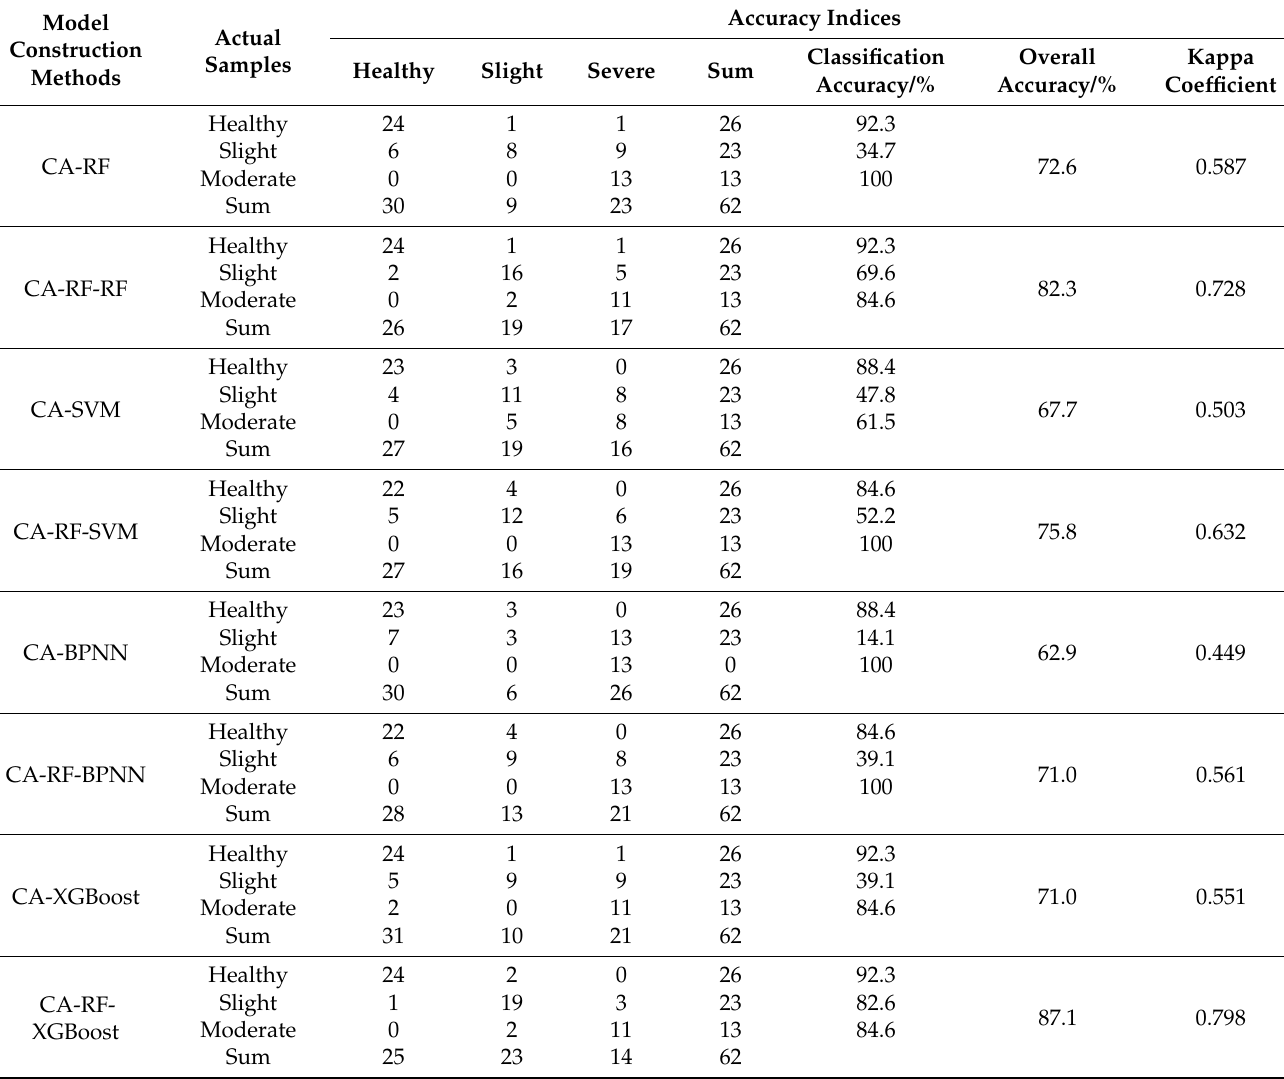
Table 4. Analysis and verification results of different detection